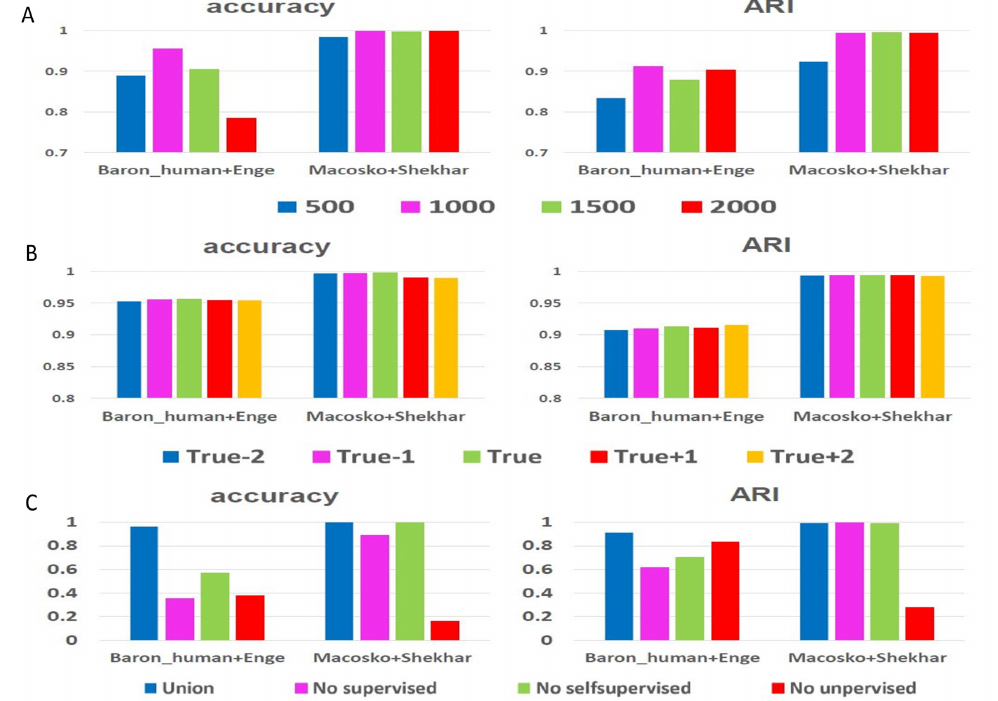
Figure 6. Ablation study on the inter-datasets. ( A – C ) Histograms of ARI and annotation accuracy values for scAnCluster in three groups of case control experiments on two inter-datasets,